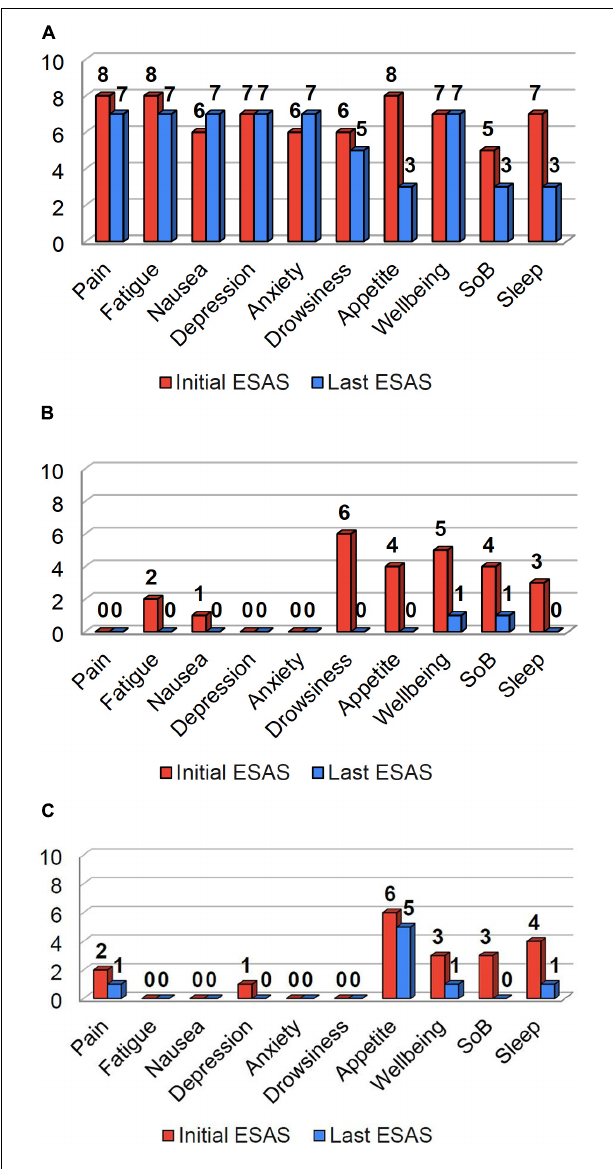
FIGURE 1 | Initial (red) and last ESAS scores (blue) for patients in cases 1-3 are shown above. The patient in Case 1 (A) , reported pain, fatigue, and loss of appetite as their most significant symptoms. The patient in Case 2 (B) reported drowsiness, loss of appetite, well-being, and shortness of breath as their most significant symptoms. The patient in Case 3 (C) reported loss of appetite, wellbeing, shortness of breath, and poor sleep as their most significant symptoms. Following treatment, there was a substantial decrease in symptom burden for all three patients (A–C) , with improvements in a majority of their individual and total ESAS